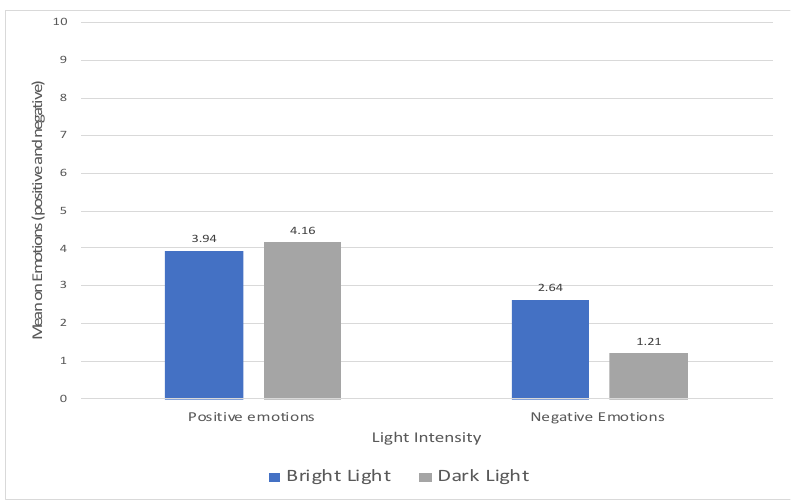
Figure 9. Effect of light intensity on positive and negative emotions .